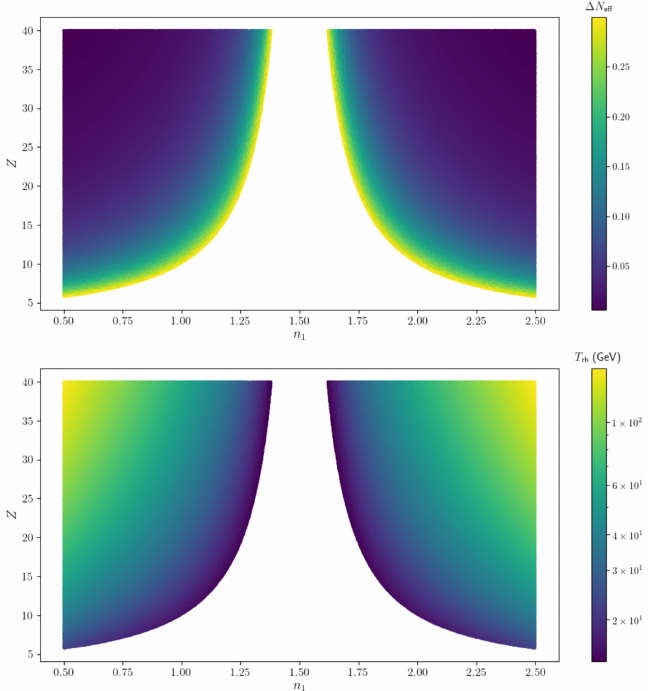
Figure 1 . The upper plot shows allowed ∆ N eff for the case k 1 = k 2 = 1 / 2 in the ultralocal limit. The lower plot shows the corresponding reheat temperature in GeV for the benchmark mass